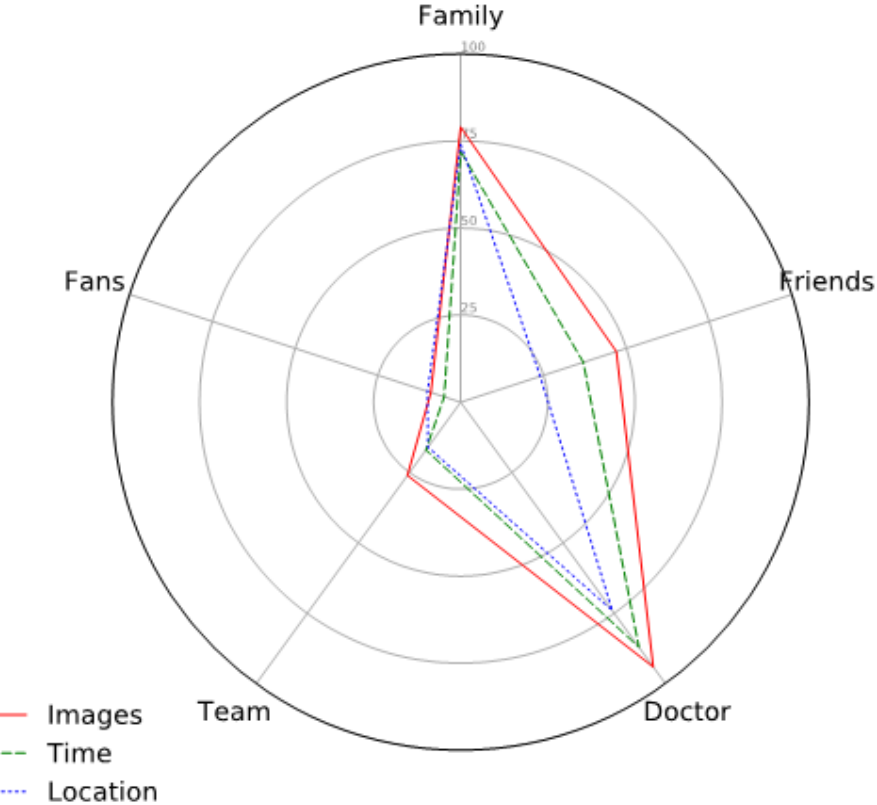
Figure 3. Radar plot showing willingness to share information with different social